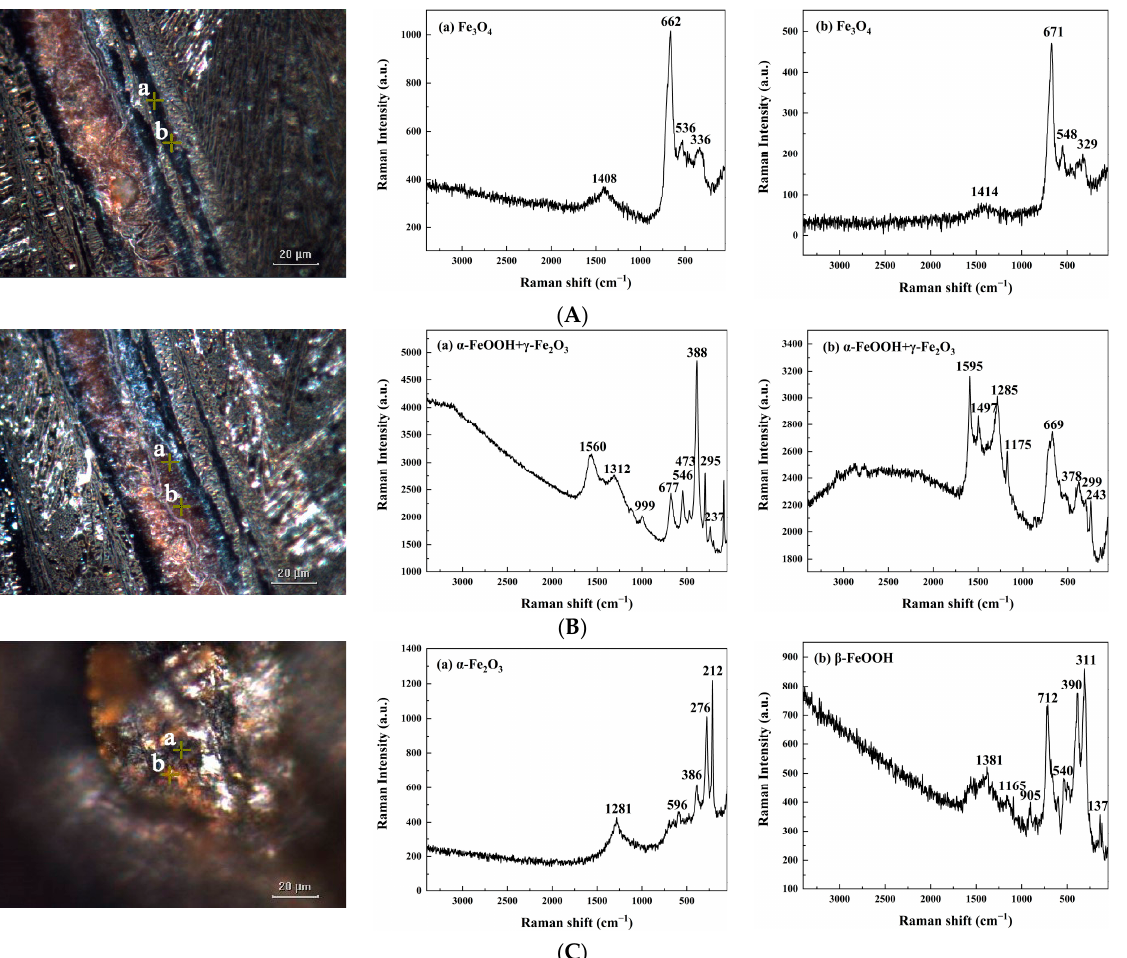
Figure 8. Raman spectrum of rust products conversion of the forming and development of microcracks in the inner matrix of iron pot samples from the “Nanhai I” shipwreck. Morphology and Raman spectrum of ( A ) the single corrosion strip at the initial forming of fractures; ( B ) the double corrosion strips at the development of fractures; ( C ) the fractures after